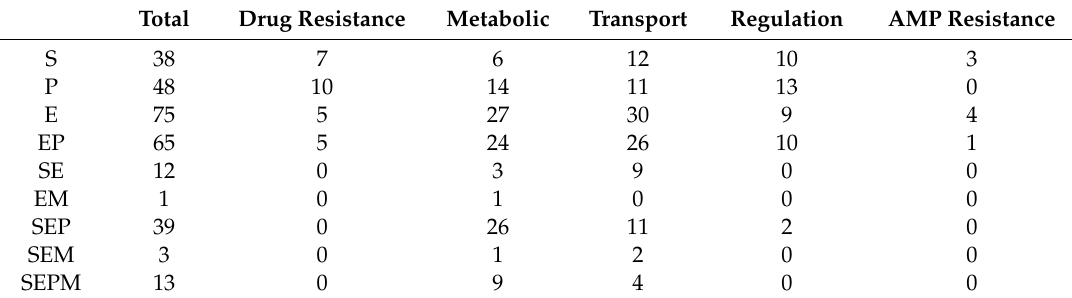
Figure 1. Venn diagram of the occurrence of different KEGG modules ( A ) and the presence of different pathways ( B ) in the organisms. S, E, P, and M indicate ellipses corresponding to S. aureus , E. cloacae , P. aeruginosa , and M. mobile . Table 2. Distribution of modules among categories and subcategories. S, E, P, and M indicate the presence of organisms in certain categories and represent S. aureus , E. cloacae , P. aeruginosa , and M. mobile , respectively. Total Drug Resistance Metabolic Transport Regulation AMP